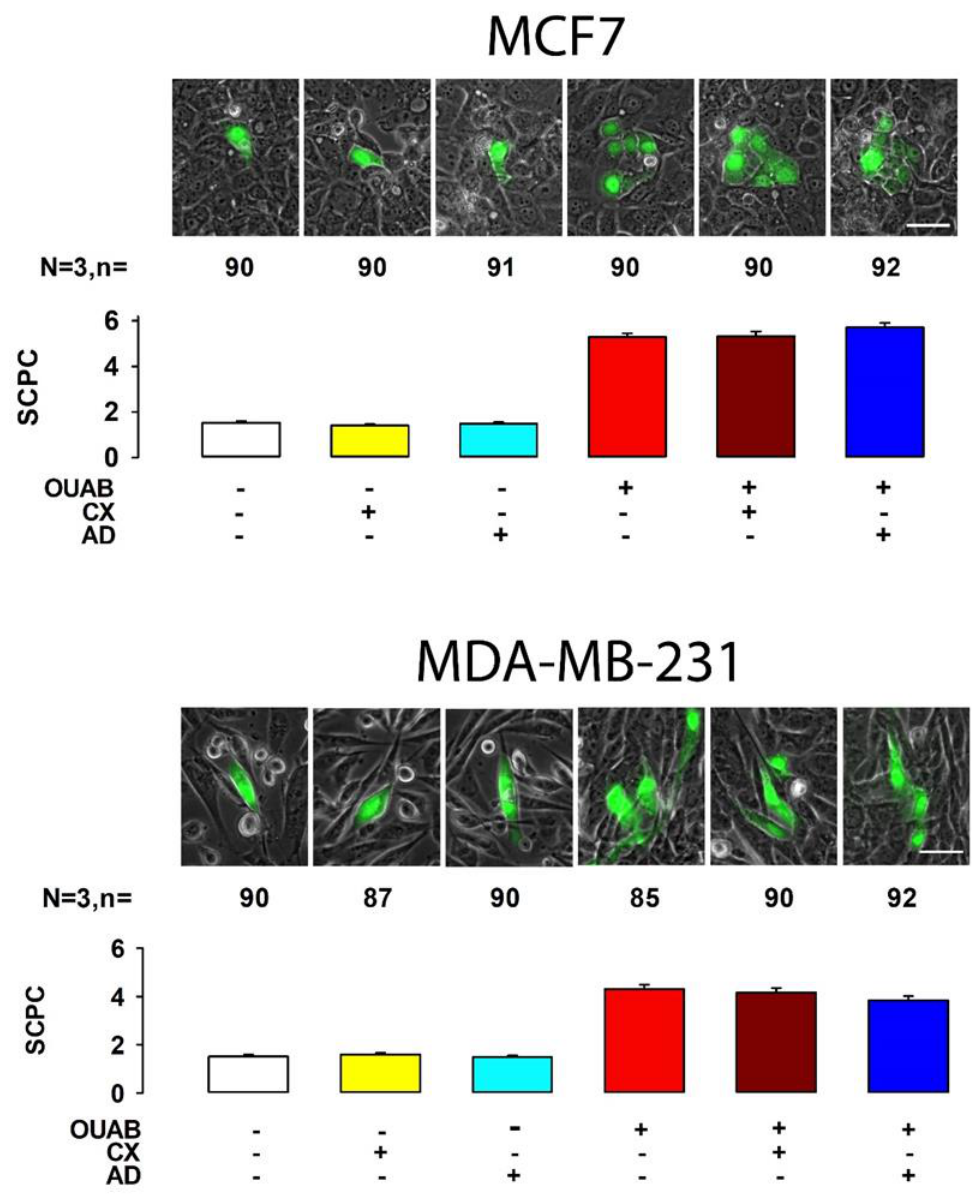
Figure 5. Effect of actinomycin D and cycloheximide on the enhancement of GJIC induced by ouabain in breast cancer cell lines (MCF7 and MDA-MB-231). Each set shown in the upper part represents images of each experimental condition. The lower bar chart compares the mSCPC ± SE of each experimental condition. Scale bar length = 50 µM.